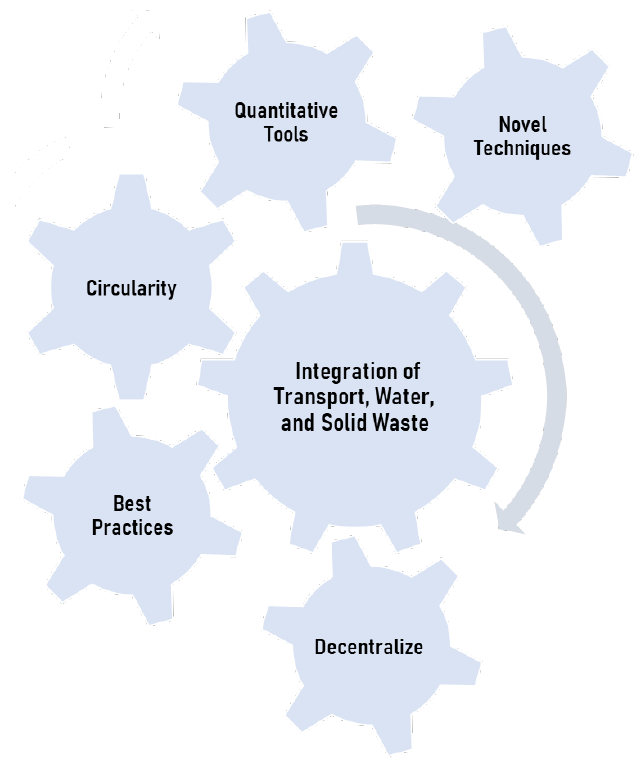
Figure 2. Interdependencies and integration opportunities.